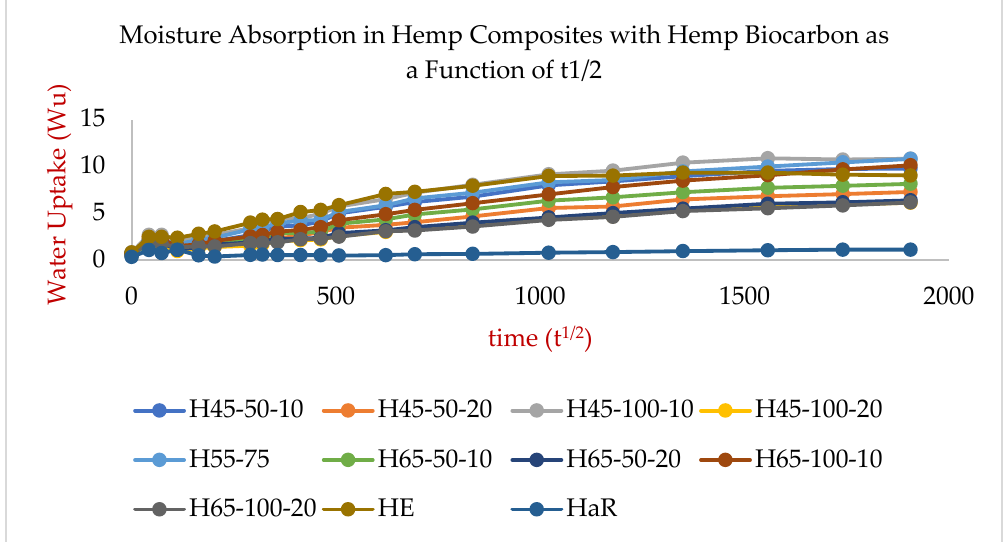
Figure 6. Water uptake nature of various hemp-biochar composites as a function of the square of time.